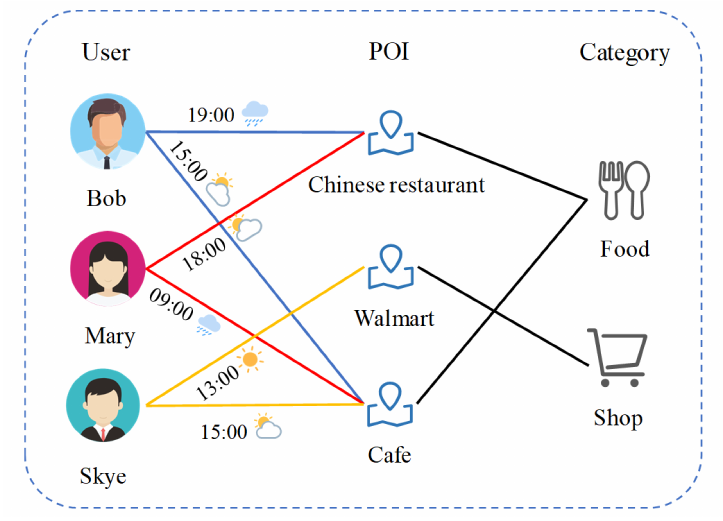
Figure 1. An example of Location-Based Social Network (LBSN) Heterogeneous Information Network (HIN) of user-Point-Of-Interest (POI)-category with contexts of time and weather.